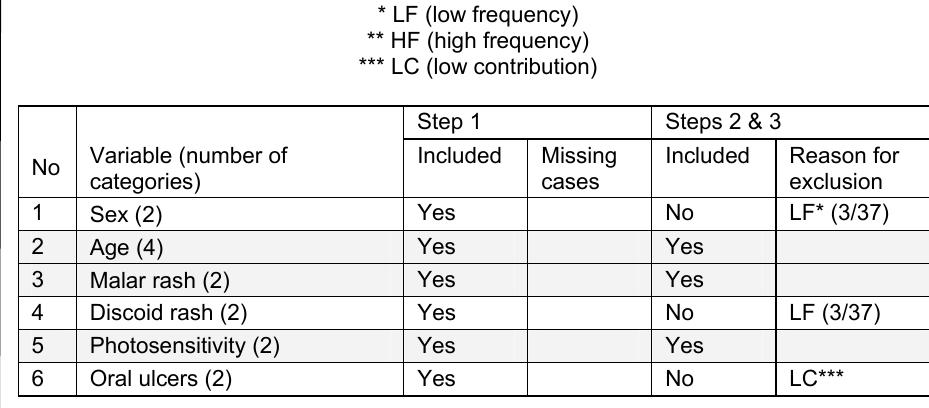
Таблица 1 – Список всех